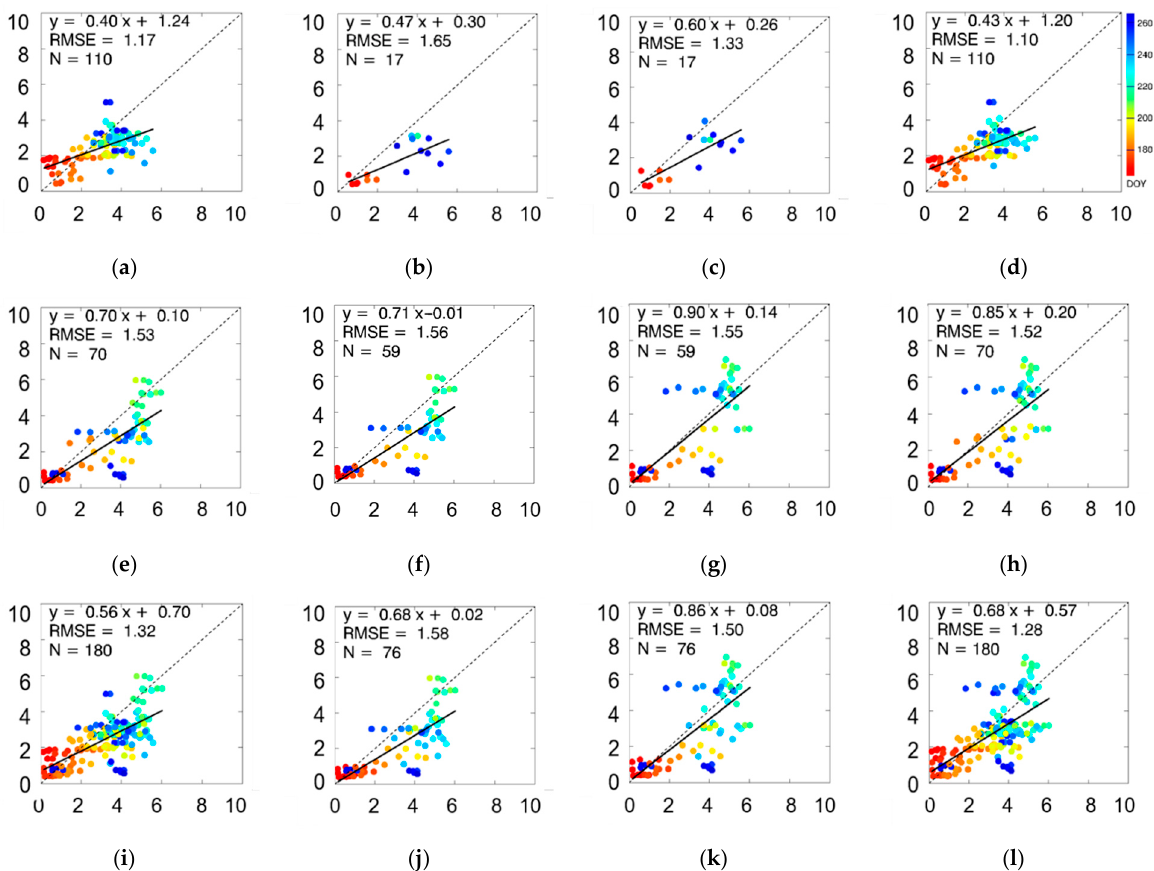
Figure 7. Comparison of the estimated LAI values to the field-measured data for paddy rice in Honghe ( a – d ), for maize, soybean, and sorghum in Hailun ( e – h ), and for all crops ( i – l ) based on MODIS BRDF parameters with high quality. The colours indicate the different observation dates. The estimated LAIs in the four columns from left to right are obtained based on the wide search method, the wide search method using local search data, the local search method, and the fused results from the wide and local search methods. Table 5. Estimation accuracy of the LAI for pixel-to-plot comparison based on high-quality MODIS BRDF data. Dataset